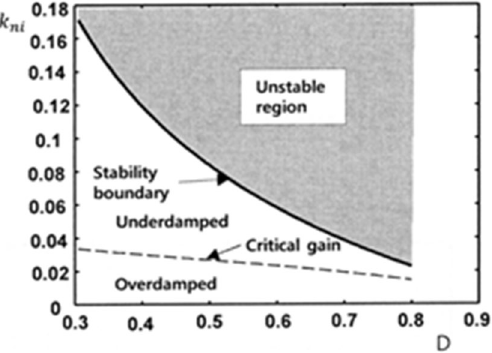
Figure 7. Theoretical stability boundary and critical gain curve of k ni as a function of D when k p = 0.